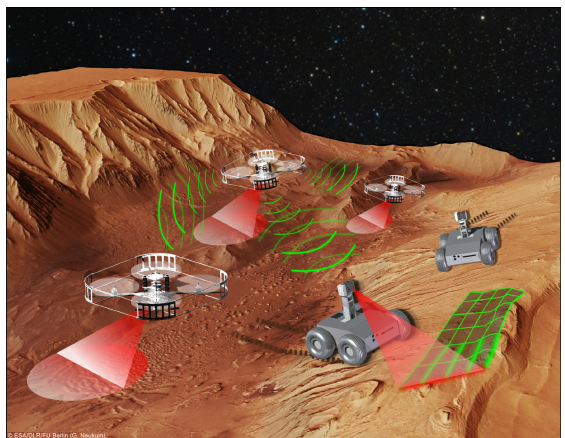
Figure 1: Possible rover formation for Martian swarm exploration One key question is if UAVs will be able to fly in the atmosphere of Mars, and which technical innovations will be needed in order to do so. However, in this work rather the problem of a robust navigation will be the focus. Due to the required time for trans- mission of radio signals between Mars and Earth, remote con- trolled interactions with a rover have a dead time between 6 and 60 minutes depending on planetary constellation. Thus the di- rect and manual control is only possible for slow-moving ground vehicles and therefore especially flying vehicles must have auto- matic routines for a safe operation. In general a rover requires information about its states, surrounding terrain and the posi- tion relative to other swarm participants. Hence, the implementa- tion of a robust navigation method includes complementary self- positioning and relative positioning systems. In this context the idea of a comprehensive SLAM concept